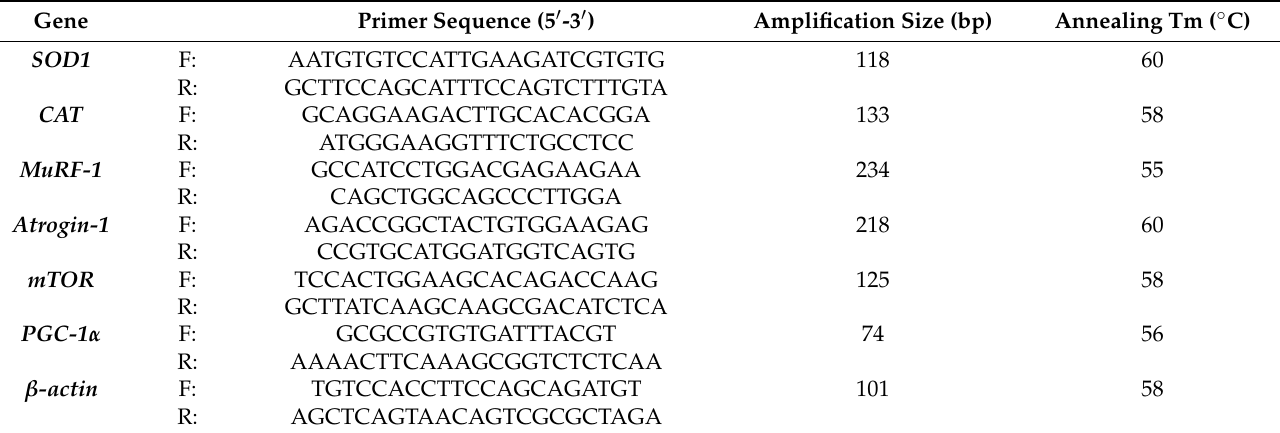
Table 1. Primer sequences for polymerase chain